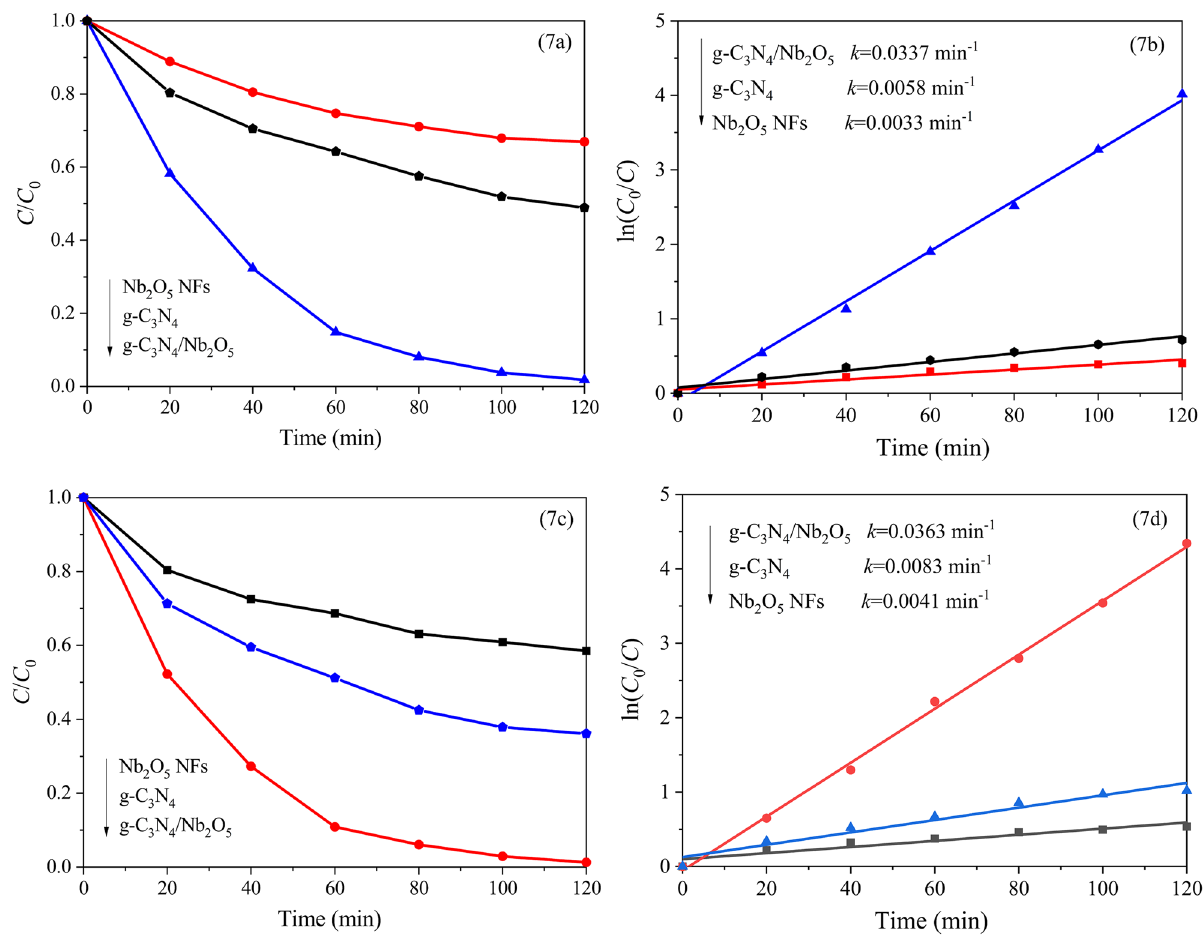
Figure 7. The degradation efficiency of ( a ) RhB and ( b ) phenol, kinetics curves for ( c ) RhB and ( d ) phenol over